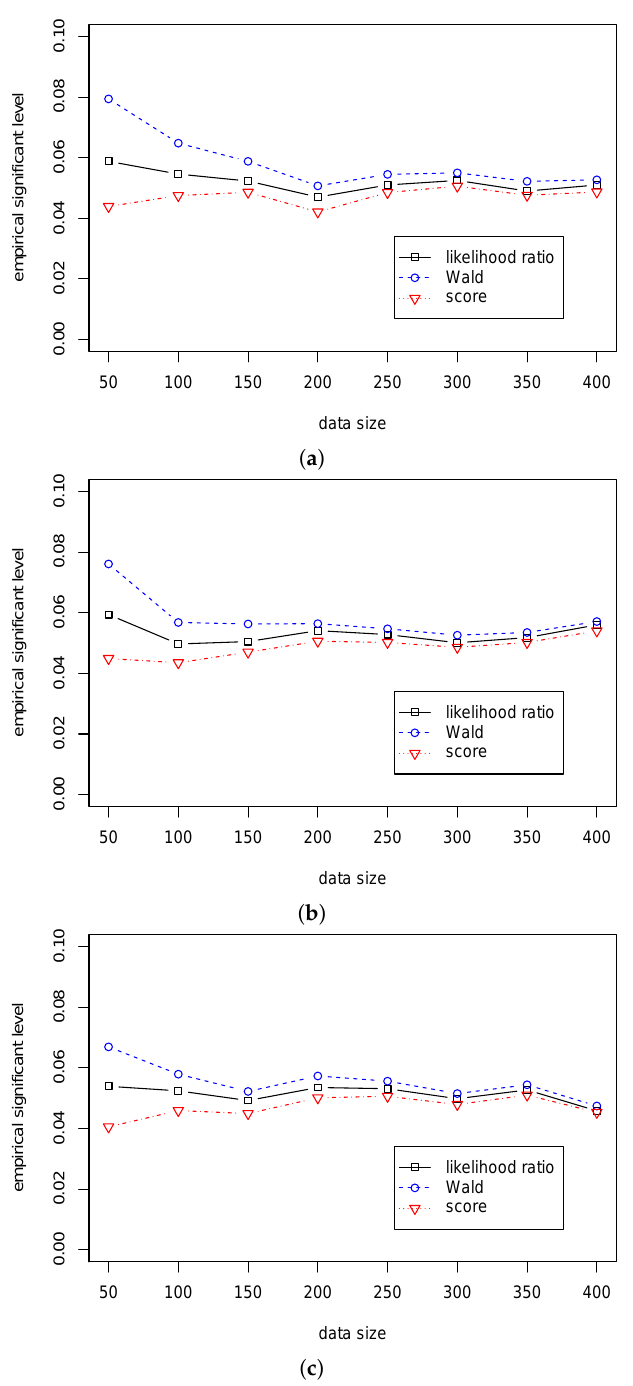
Figure 3. The empirical levels of three test statistics ( T L , T W , T S ) for testing H 0 : β 1 = β 2 = β 3 = 0 in Case (B2) for different α . ( a ) The empirical level with H 1 : β = ( 1,0,0,0 ) (cid:62) for α = 0.75; ( b ) The empirical level with H 1 : β = ( 1,0,0,0 ) (cid:62) for α = 0.85; ( c ) The empirical level with H 1 : β = ( 1,0,0,0 ) (cid:62) for α =